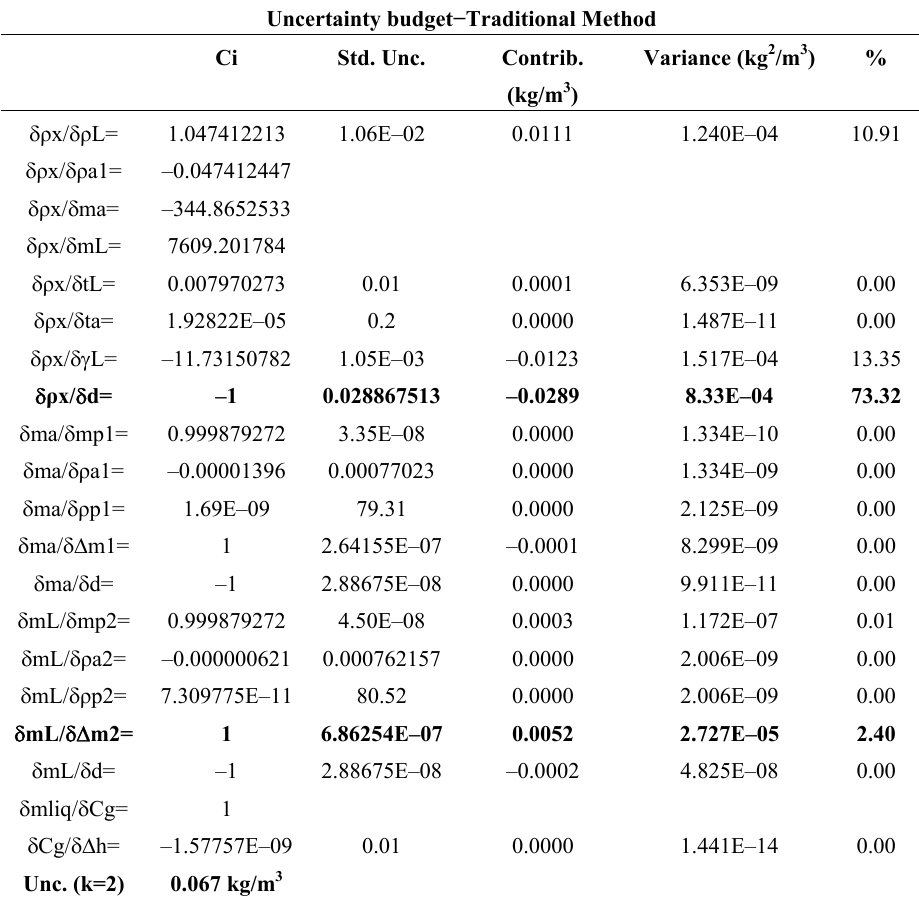
Table 10. Uncertainty budget − Traditional method − d = 0.1 kg/m 3 .